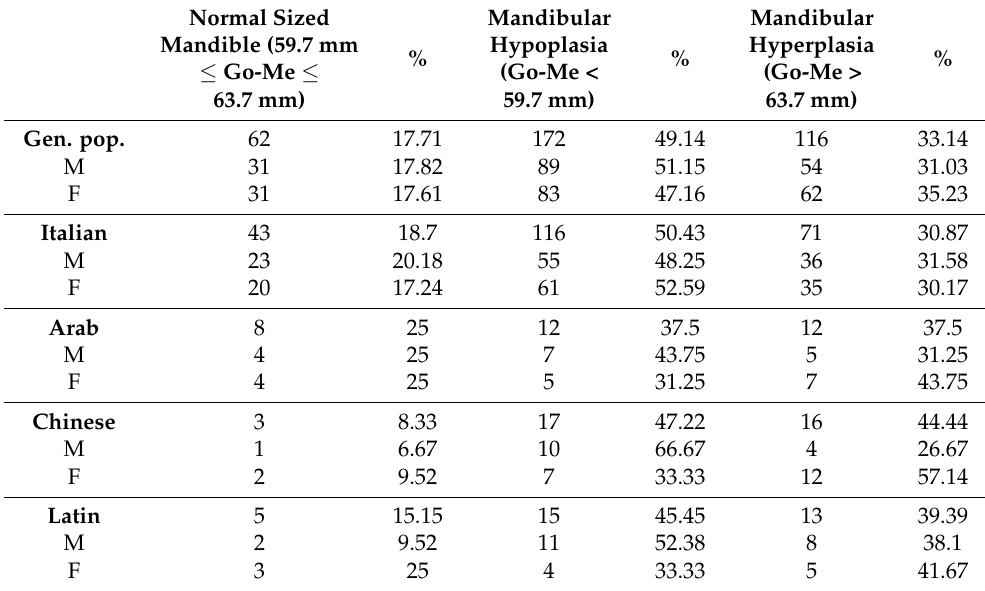
Table 7. Distribution of mandible size values in the selected patient sample. Normal